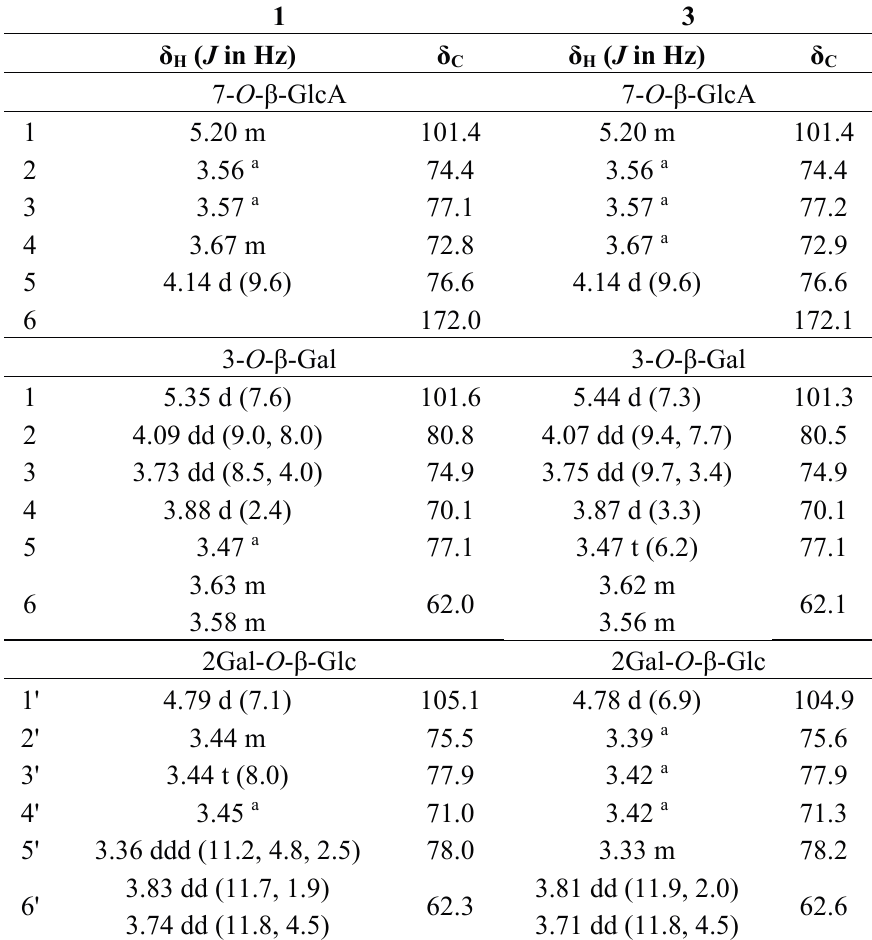
Table 2. NMR spectroscopic data (methanol- d 4 , 500 MHz) for the sugar units of compounds 1 and 3